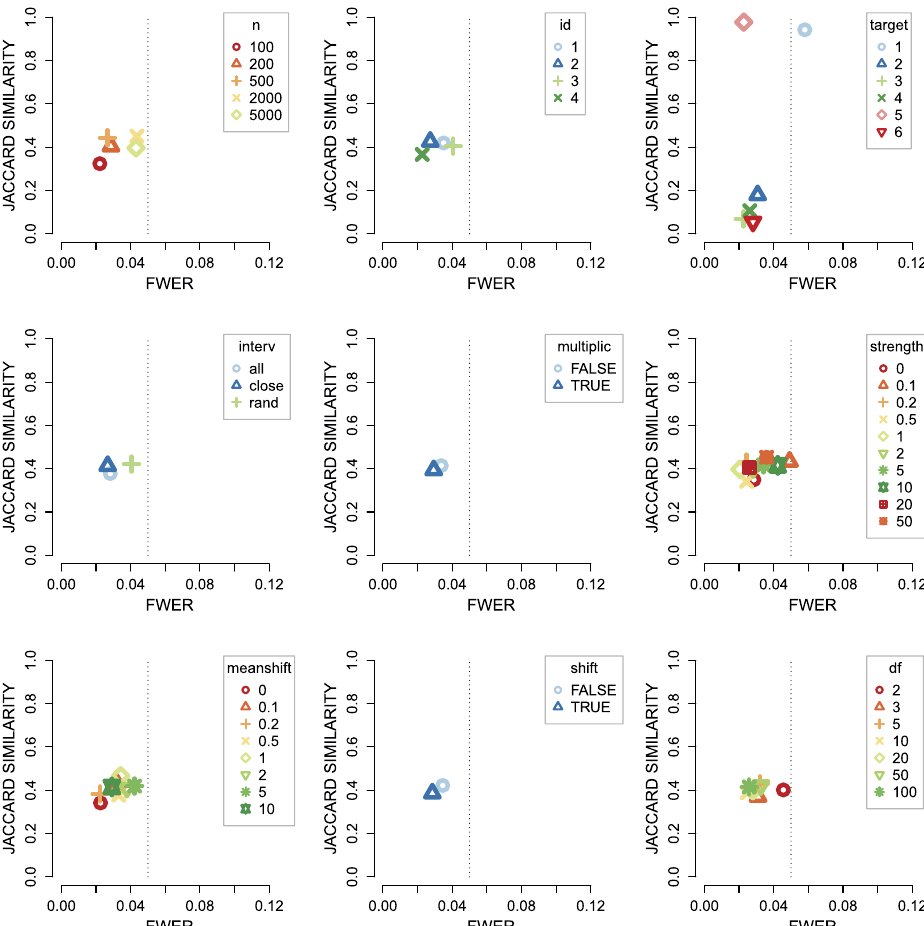
Figure 8: Average Jaccard similarity over the conditional independence tests (A)–(F) ( y -axis) against average FWER ( x -axis), strat- ified according to various parameters (from top left to bottom right): sample size ‘n’, type of nonlinearity ‘id’, ‘target variable’, intervention location ‘interv’, multiplicative effects indicator ‘multiplic’, ‘strength’ of interventions, mean value of interventions ‘meanshift’, shift intervention indicator ‘shift’ and degrees of freedom for t-distributed noise ‘df’. For details, see the descrip- tion in Appendix III. The FWER is within the nominal level in general for all conditional independence tests. The average Jaccard similarity is mostly determined by the target variable under consideration, see top right